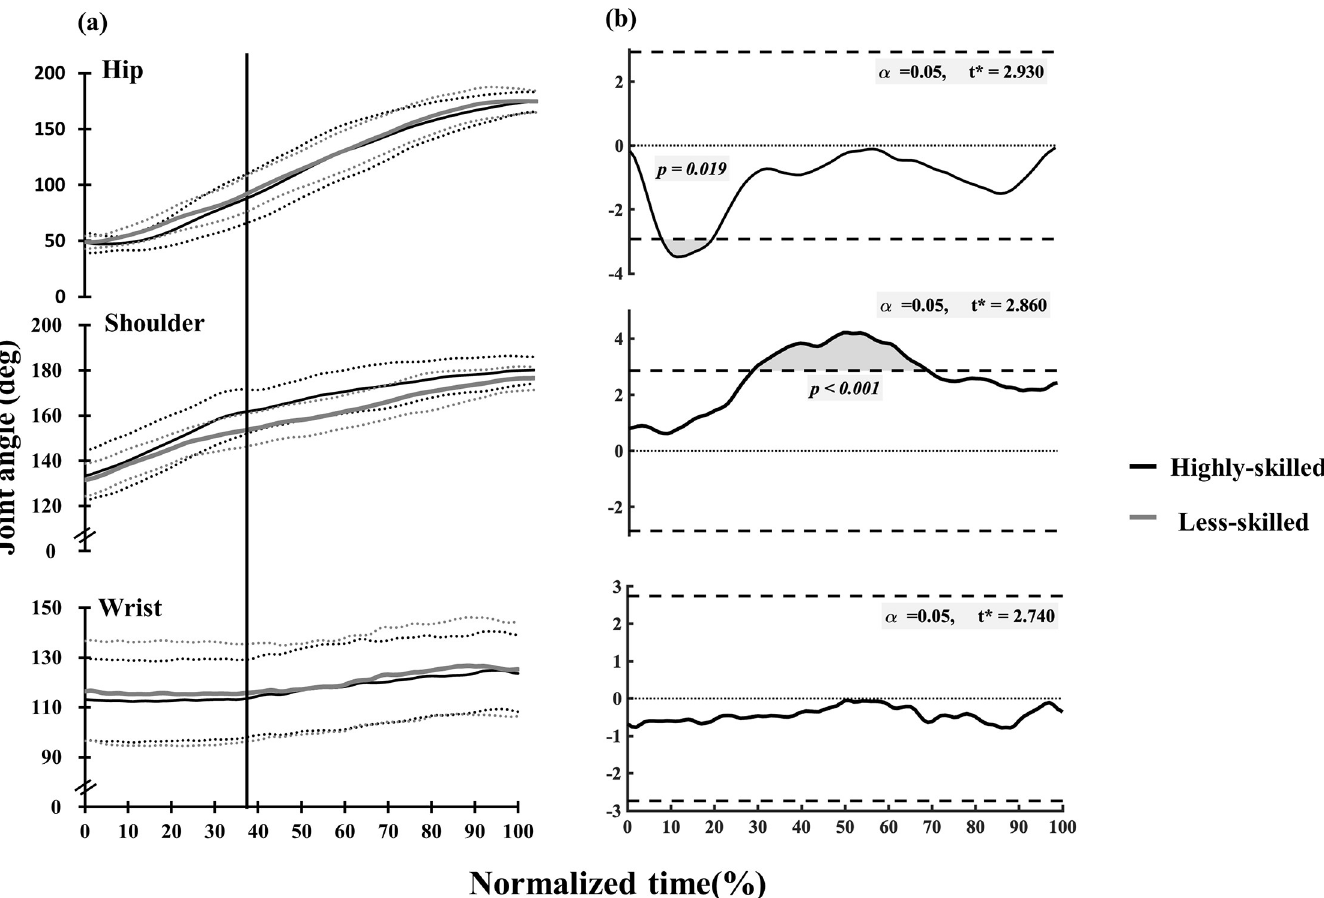
Fig 6. Changes in mean values of joint angles (a) and statistical parametric mapping (SPM) (b) between highly-skilled and less-skilled. Horizontal axis indicated normalized time of SAPH defined as 100% from Toe-off to Handstand. Dotted lines indicated mean ± one SD. Vertical line indicated the timing of Leg horizontal position. Associated SPM t-test results for differences between the curves in (A). The shaded area indicates suprathreshold clusters, which correspond to statistically significant differences between the curves at those nodes (percentage of normalized time).